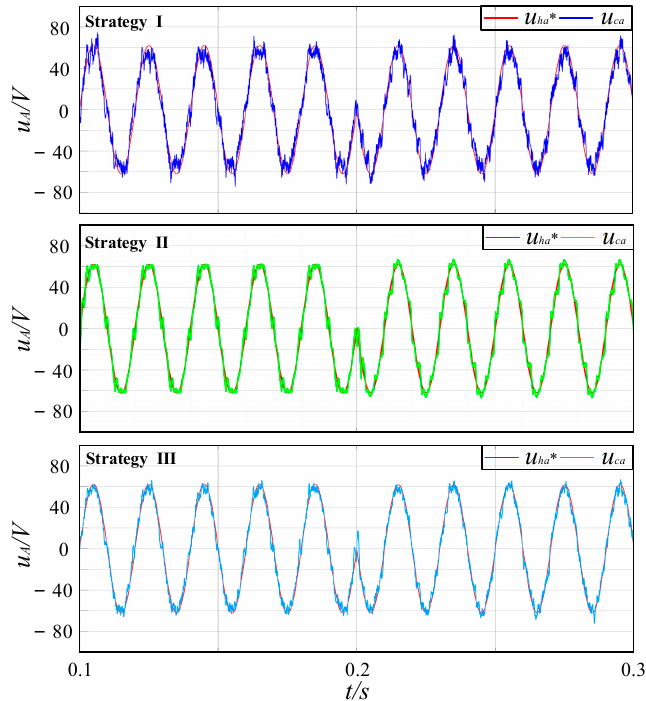
Figure 8. Detail of load voltage at 0–0.1 s.